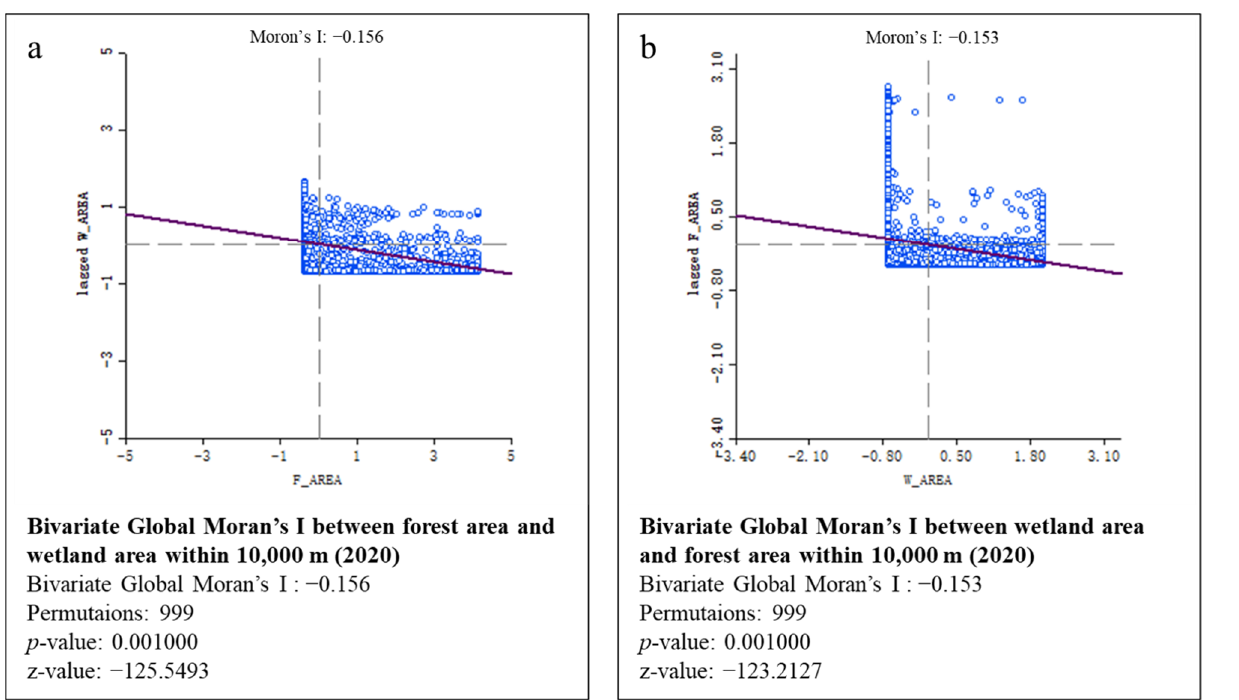
Figure 7. Bivariate Global Moran's I between forest area and wetland area within 10,000 m in Tianjin (2020) ( a ), Bivariate Global Moran's I between wetland area and forest area within 10,000 m in Tianjin (2020) ( b ).